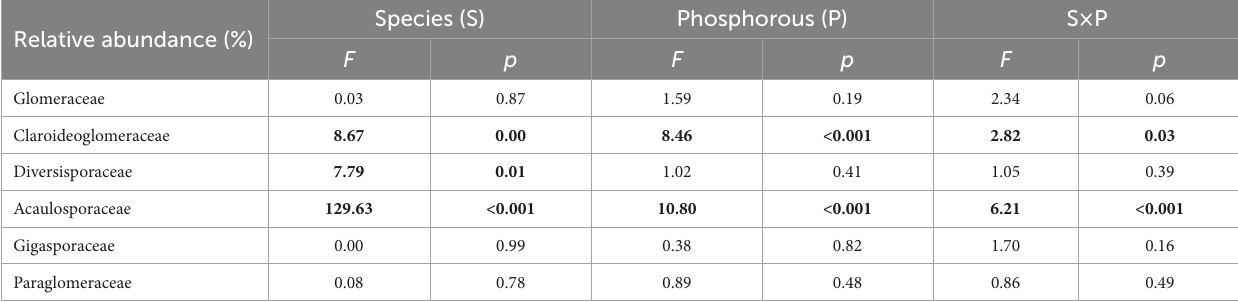
Significant effects are shown in bold ( p <